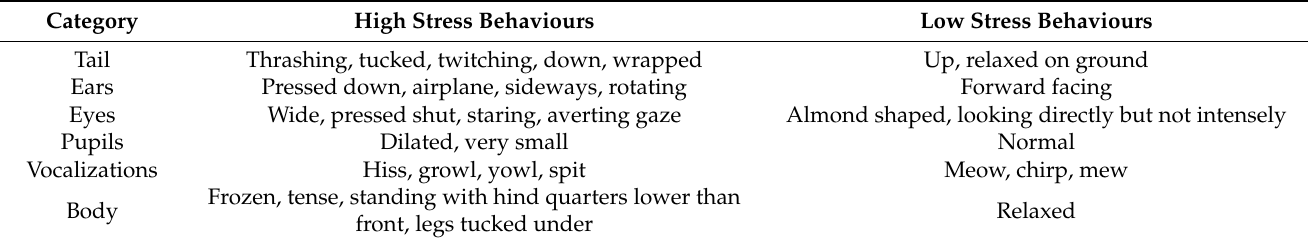
Table 2. Definitions of high and low stress behaviours to aid in assigning an FAS score between adapted FAS